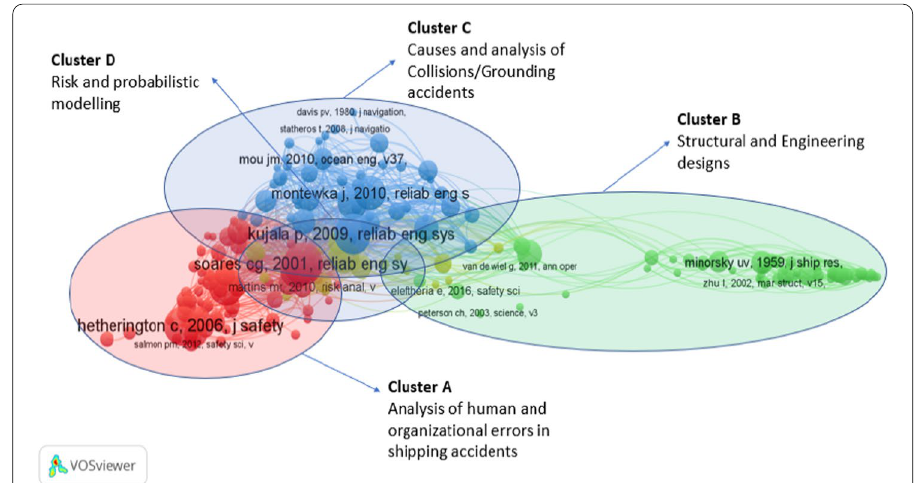
Fig. 2 CCA clusters based on keywords “Shipping